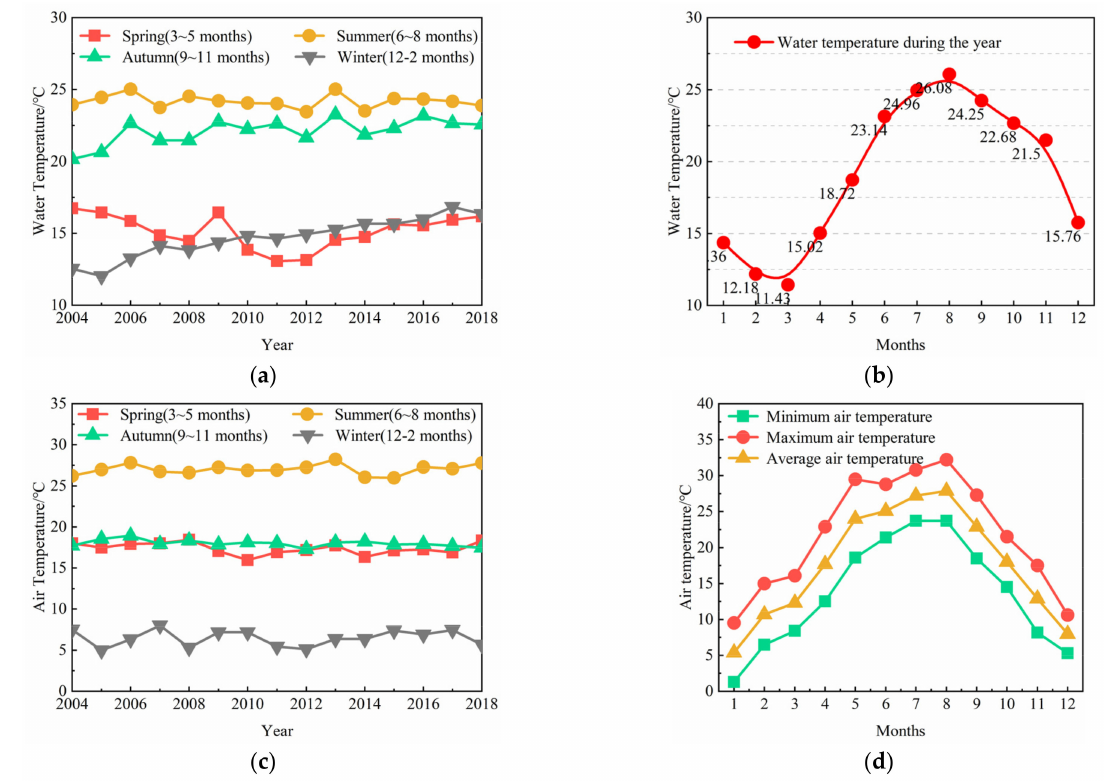
Figure 7. Measured temperatures data of the Three Gorges HPP: ( a ) the water temperatures from 2004 to 2018; ( b ) the water temperatures in 2007; ( c ) the air temperatures from 2004 to 2018; ( d ) the air temperatures in 2007.